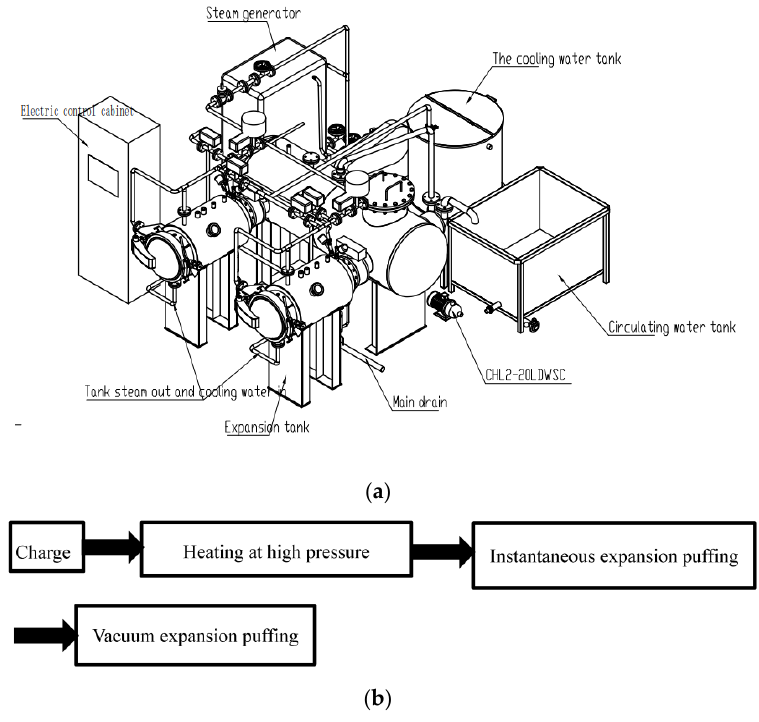
Figure 1. ( a ) . Puffing-drying system entity diagram. ( b ) . Process flow chart. Figure 1. ( a ). Puffing-drying system entity diagram. ( b ). Process flow